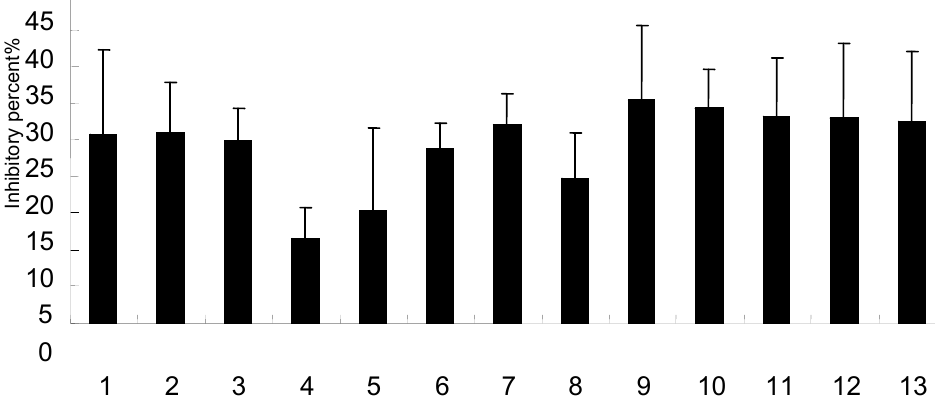
Note: n = 3, each value represents the mean 